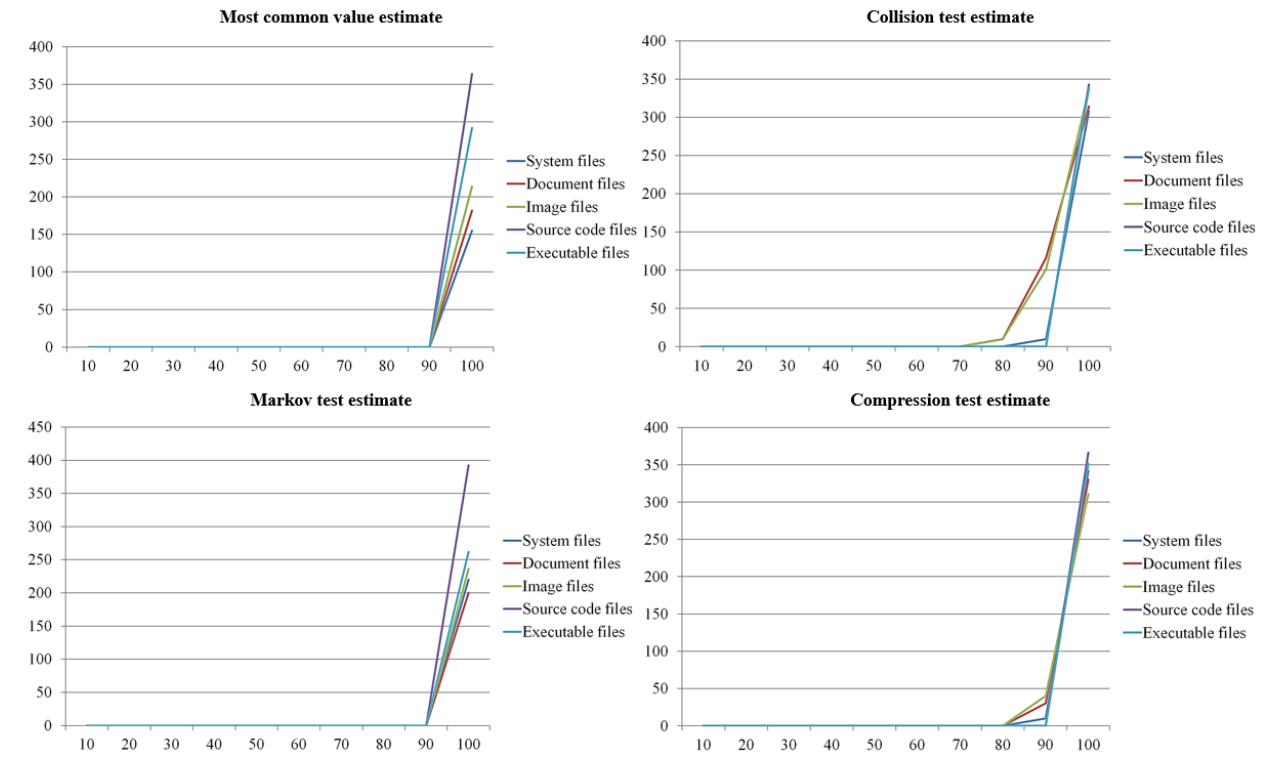
Figure 10. Total number of true-negatives files.